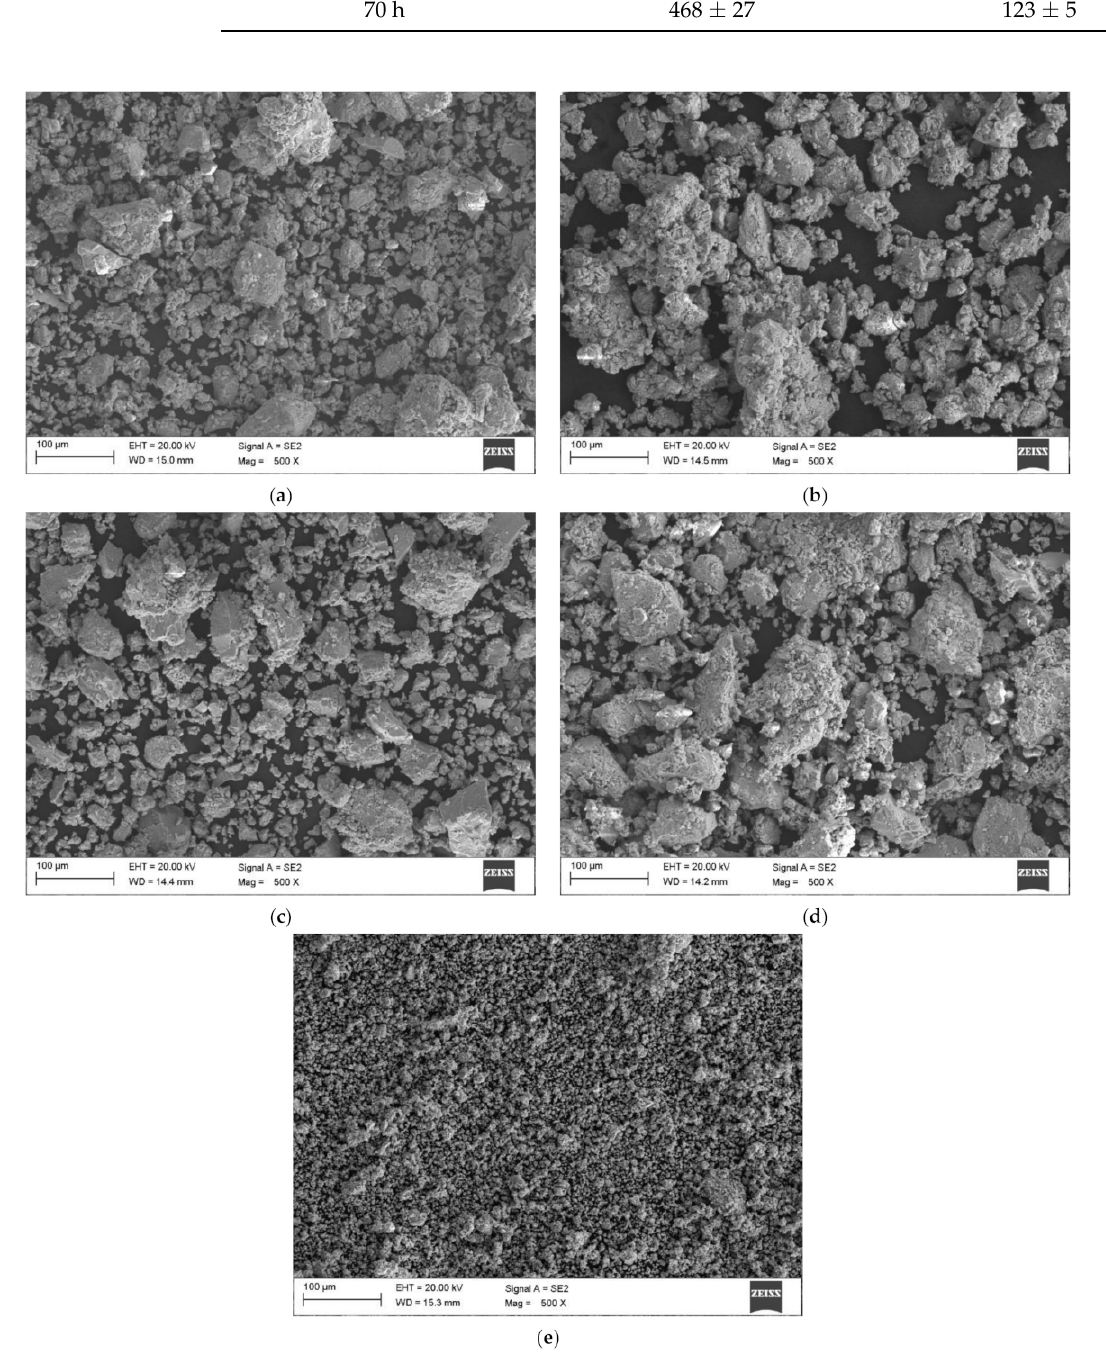
Figure 7. Scanning electron microscope micrographs of Mg-Zn-Ca-Pr powders milled with EDS (energy dispersive spectroscopy), results for ( a ) 8, ( b ) 13, ( c ) 20, ( d ) 30 and ( e ) 70 h,